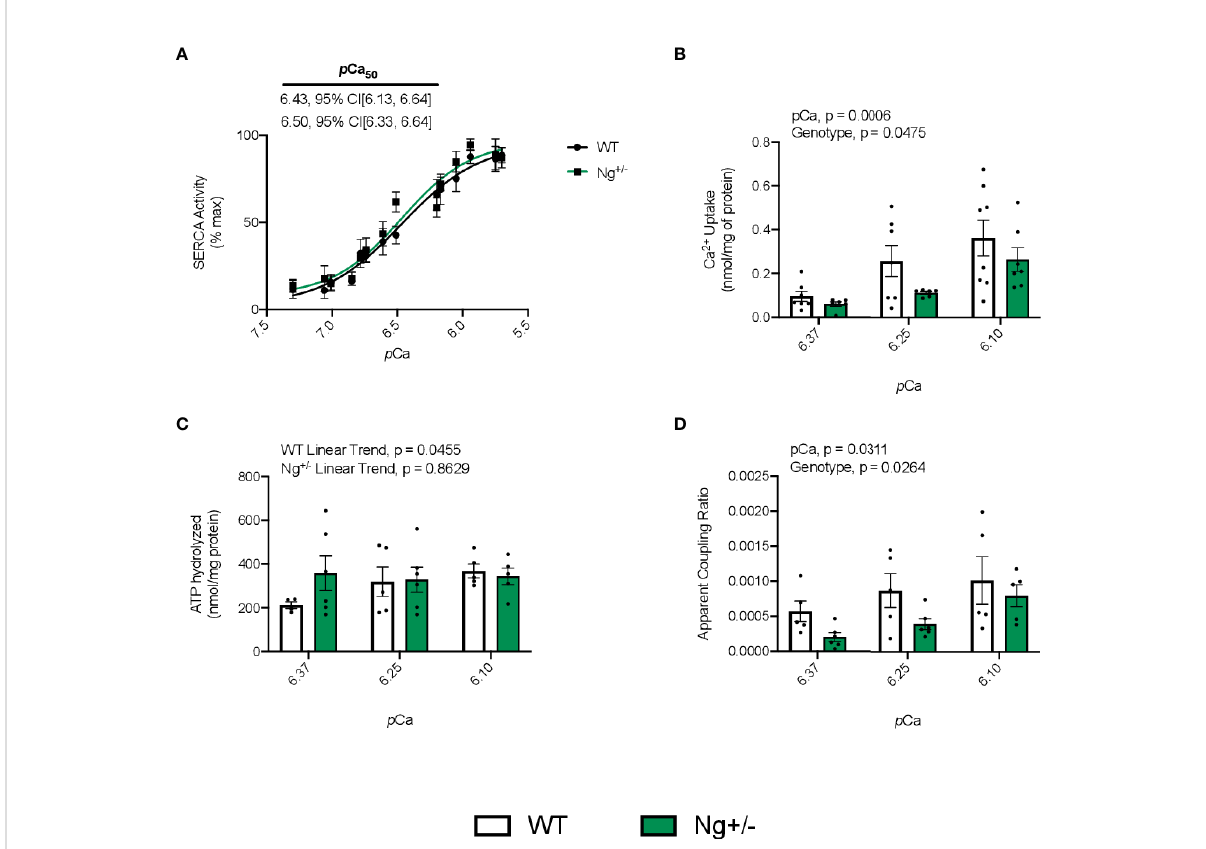
FIGURE 3 Soleus SERCA pump ef fi ciency is reduced in Ng +/- mice compared to WT. Representative curves of SERCA ATPase activity with SERCA ’ s Ca 2+ af fi nity measure, p Ca 50 , embedded with 95% con fi dence intervals (A) . Quantifying SERCA Ca 2+ uptake over three different p Ca intervals (6.10, 6.25, 6.37) shows a signi fi cant main effect of p Ca and genotype (B) . Calculating the amount of ATP hydrolyzed across the same three p